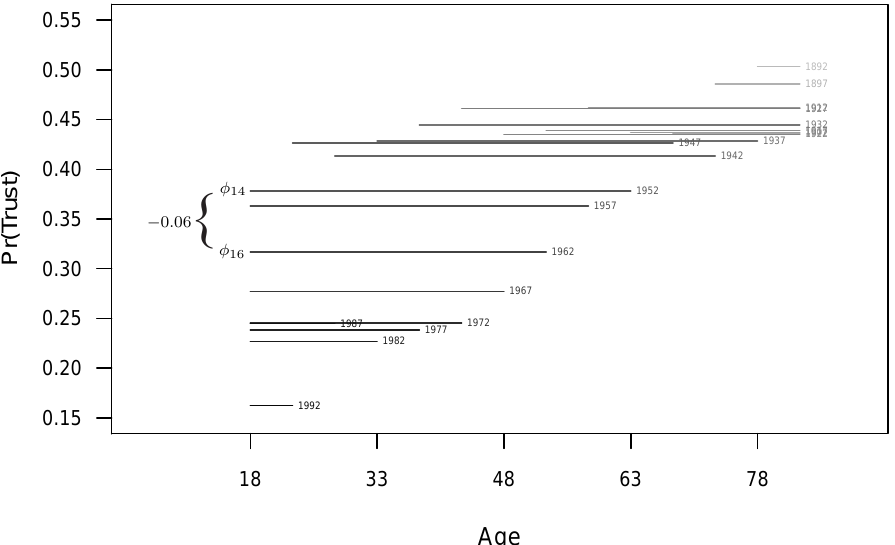
Figure 13: Comparative cohort careers in absence of life-cycle change. Notes: Graph displays comparative cohort careers under the hypothetical scenario of no life-cycle change (i.e., no intra-cohort trends). The vertical distance from the intercept for each horizontal line is given by ϕ k = θ 2 ( k − k ∗ ) + each horizontal line is equal to the number of observed age categories. For example, the k = 14 cohort, with a midpoint birth year of 1952, has a parameter ϕ k = 14 with a corresponding predicted probability of 0.38. By contrast, the k = 16 cohort, with a midpoint birth year of 1962, has a parameter ϕ k = 16 with a corresponding predicted probability of 0.32. Thus, the vertical distance between the careers of these two cohorts is given by the difference in predicted probabilities, or 0.32 − 0.38 = − 0.06. Only cohorts with two or more age categories are displayed. Cohort groups are labeled using midpoint values. All estimates are based on a diachronic L-APC logistic regression model. Outcome is social trust, coded so that 1 = “can trust” while 0 = “can’t be too careful” or “depends.” Results adjusted using sampling